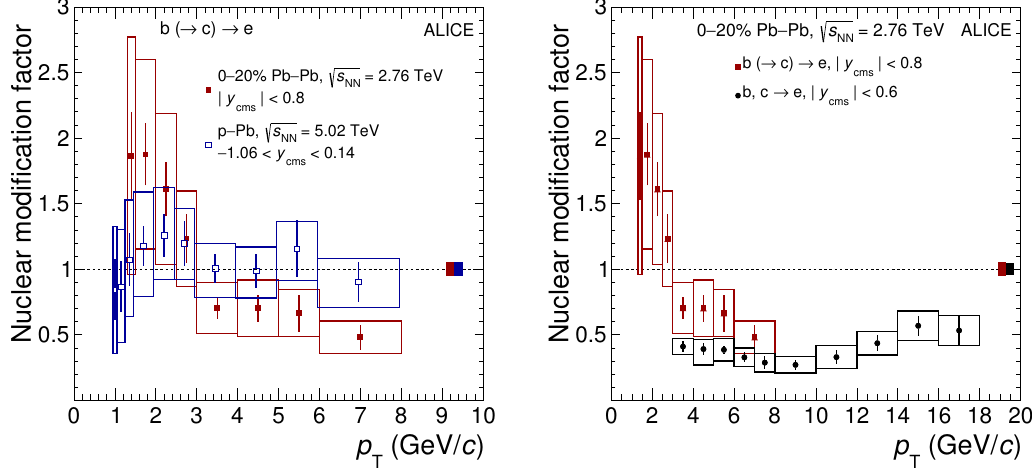
Figure 6 . (Left) Nuclear modi(cid:12)cation factors R pPb and R PbPb of electrons from beauty-hadron decays at mid-rapidity as a function of transverse momentum for minimum-bias p-Pb collisions at p p s NN = 5.02 TeV and 20% most central Pb-Pb collisions at s NN = 2.76 TeV. The data points of the p-Pb analysis were shifted by 0.05 GeV =c to the left along the p T axis for better visibility. (Right) R PbPb of electrons from beauty-hadron decays together with the corresponding result for beauty- and charm-hadron decays [89] for the 20% most central Pb-Pb collisions. The vertical bars represent the statistical uncertainties, while the boxes indicate the systematic uncertainties. The normalisation uncertainties, common to all points, are shown as (cid:12)lled boxes at high p T for all nuclear modi(cid:12)cation